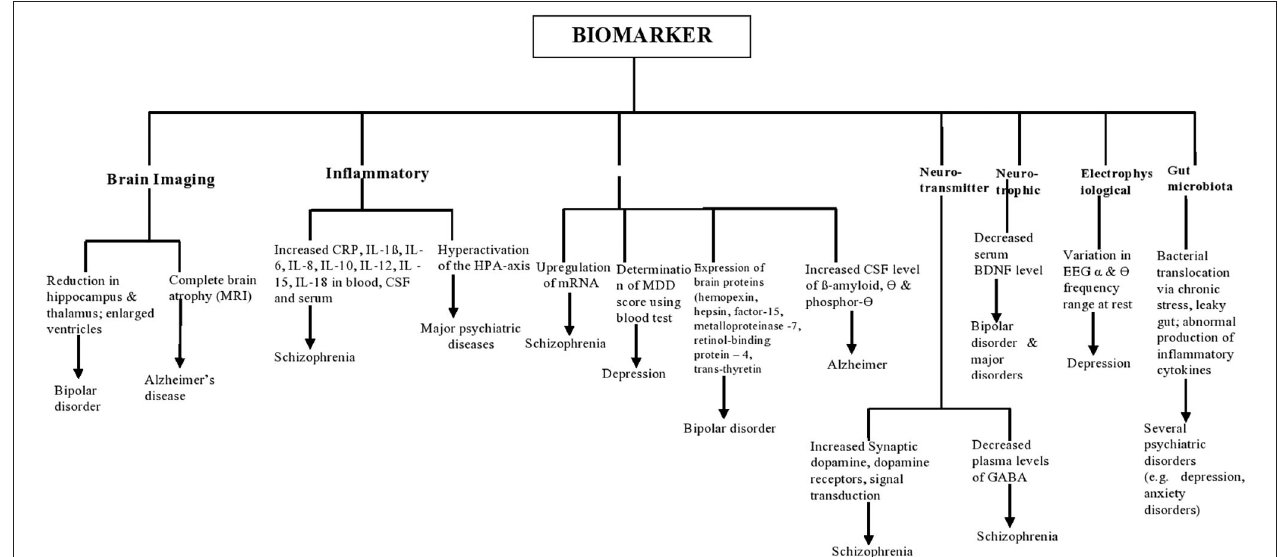
FIGURE 2 | Schematic illustration of biomarkers in some psychiatric